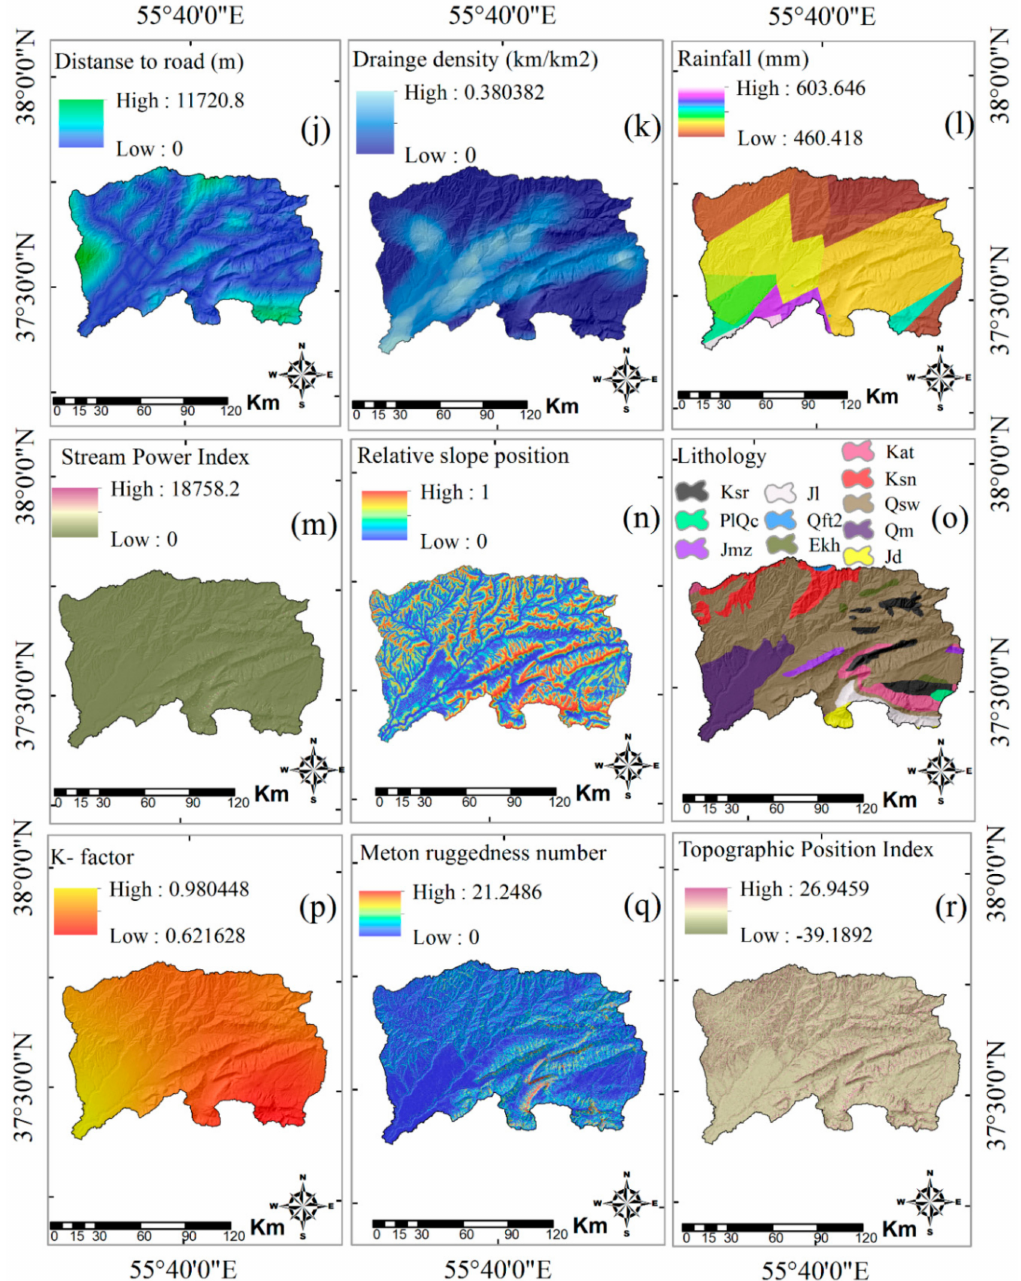
Figure 4. Gully conditioning factor maps. ( a ) Digital Elevation Model (DEM) (m), ( b ) Aspect, ( c ) Slope (%), ( d ) Profile curvature, ( e ) Plan curvature, ( f ) Land use, ( g ) Soil texture, ( h ) Topographic Wetness Index, ( i ) Distance to stream (m), ( j ) Distance to roads (m), ( k ) Drainage density ( l ) Rainfall (mm), ( m ) Stream Power Index, ( n ) Relative slope position ( o ) lithology, ( p ) K factor, ( q ) Melton ruggedness number, ( r ) Topographic Position